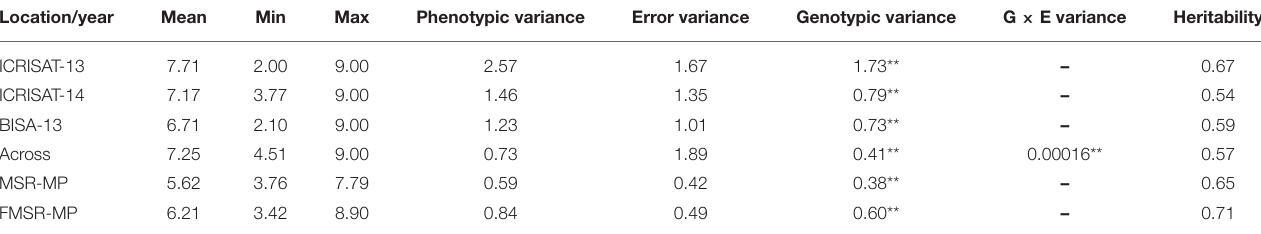
TABLE 1 | Summary statistics of CIMMYT Asia association mapping panel evaluated at three environments and two F 2 : 3 linkage mapping populations evaluated during the dry season of 2017 and 2018. Location/year